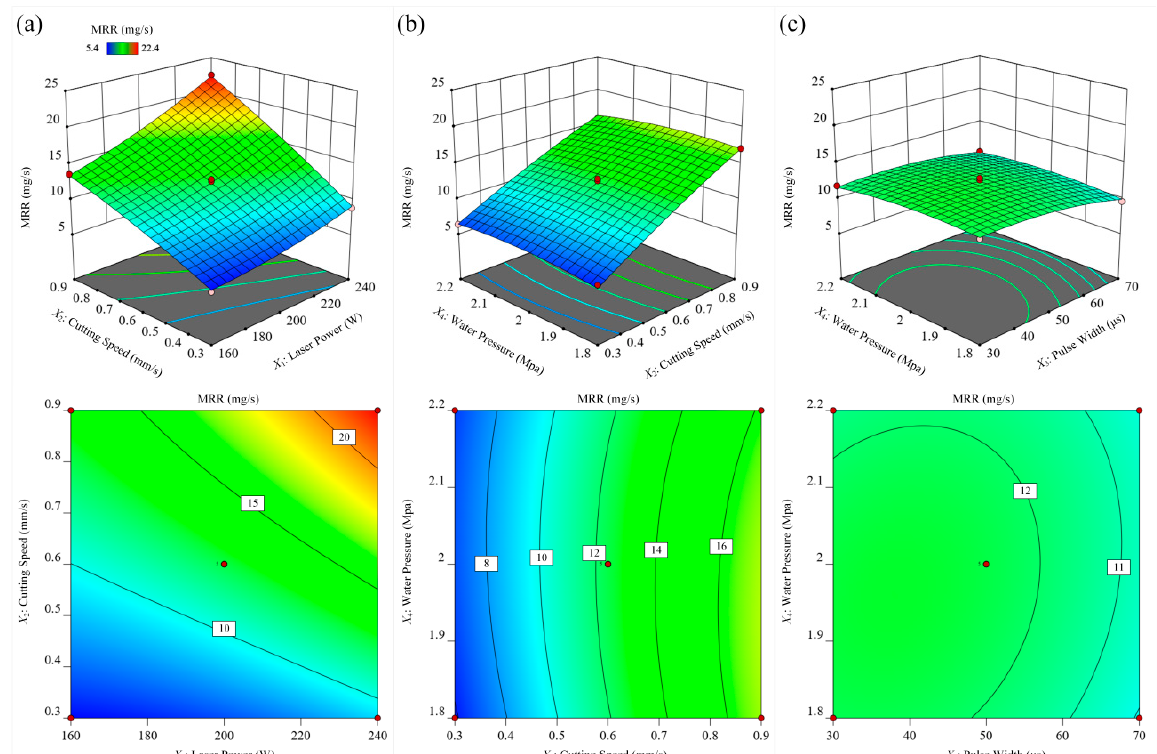
Figure 16. The influence of different process parameters on the MRR. ( a ) laser power and cutting speed; ( b ) cutting speed and water pressure, ( c ) pulse width and water pressure. speed; ( b ) cutting speed and water pressure, ( c ) pulse width and water